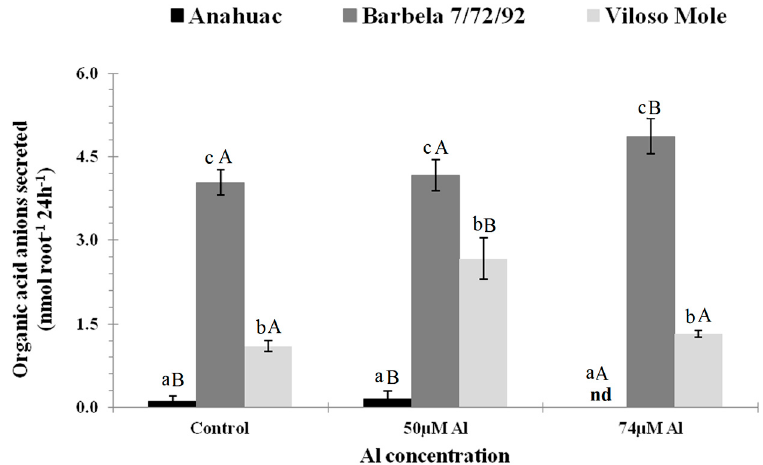
Figure 3. Effect of Al on the organic acids (OAs) secretion from the intact roots of bread wheat genotypes: Anahuac, Barbela 7/72/92 and Viloso Mole. Roots were exposed in nutrient solution (pH